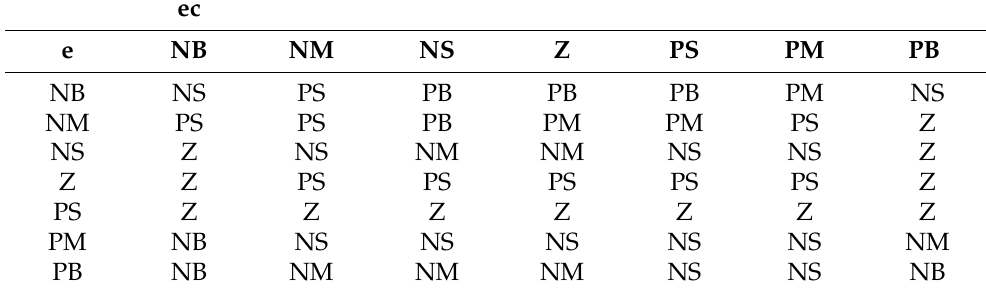
Table 5. Fuzzy control rule of ∆ µ